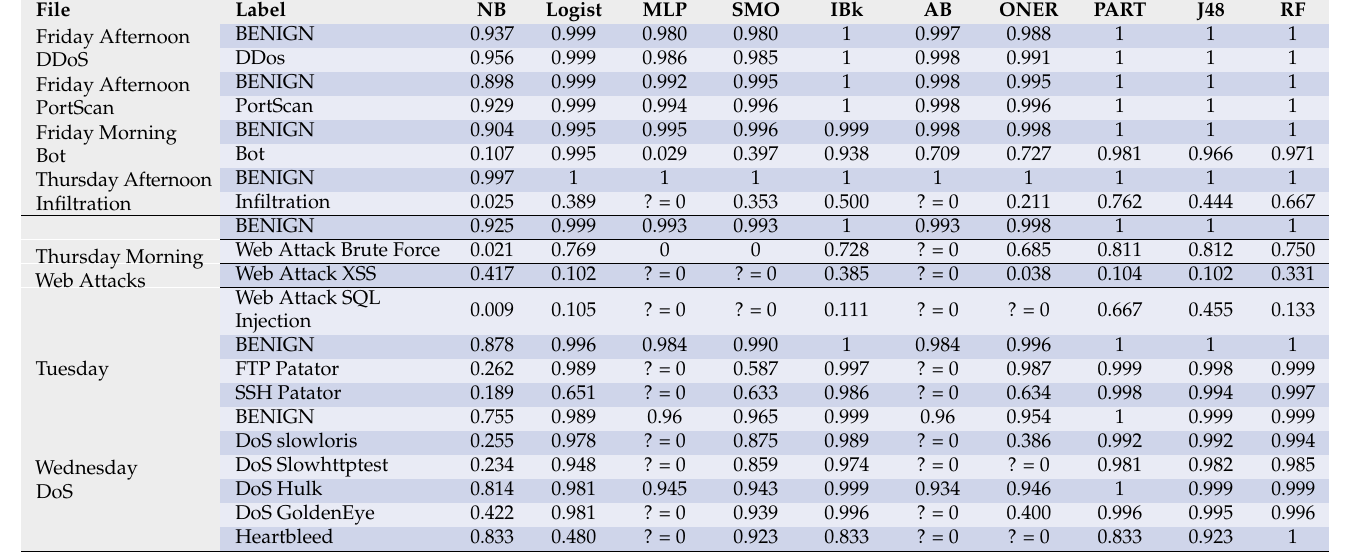
Table 9. F1 performance results obtained for each dataset file in multiclass classification.